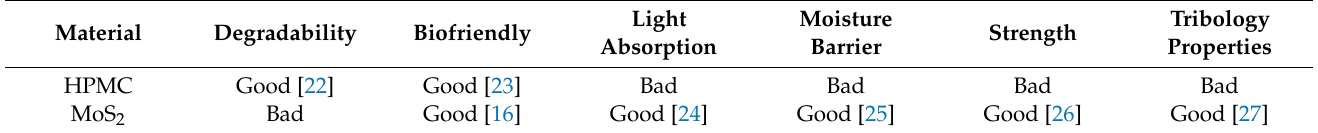
Table 2. Material properties of HPMC and MoS 2 .